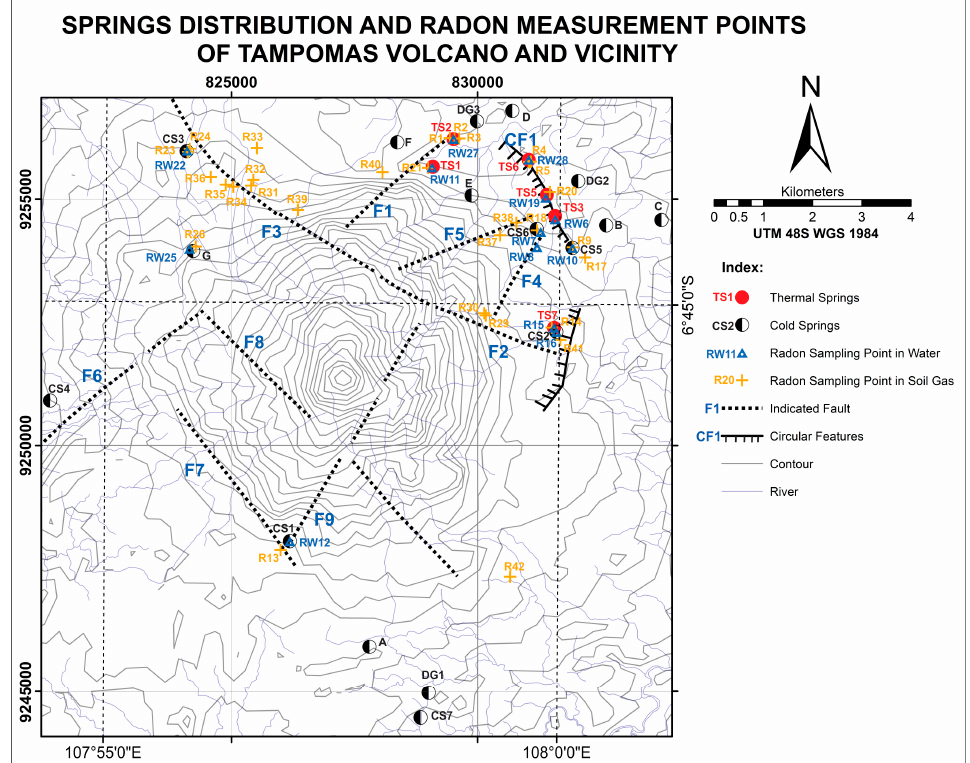
Figure 4. Interpreted geological structure map of Tampomas based on remote sensing, surface geological mapping and thermal springs’ distribution. This is overlaid with soil-gas, dissolved 222 Rn and water sample measurement point locations.